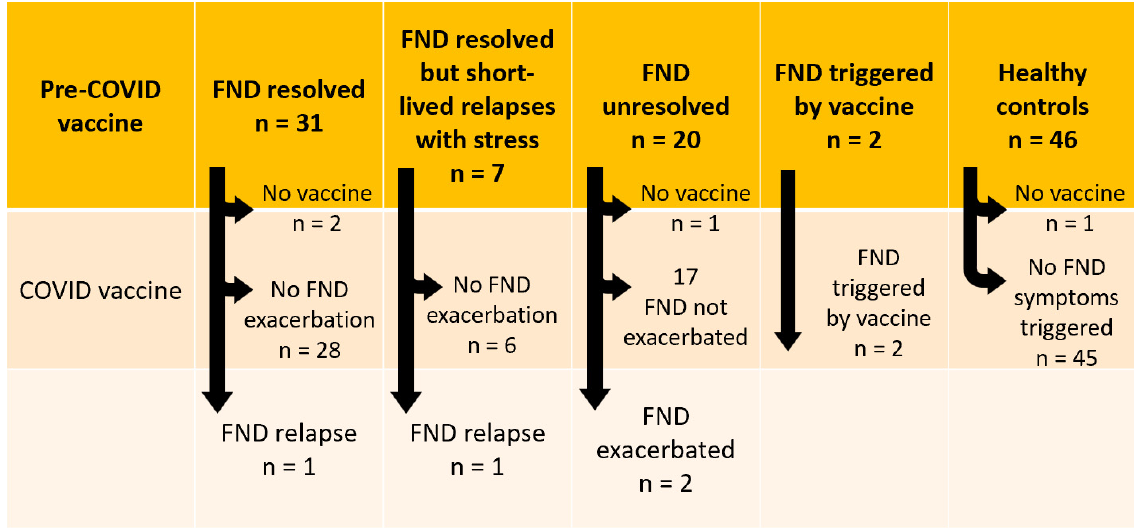
Figure 2. Visual representation of vaccination responses.